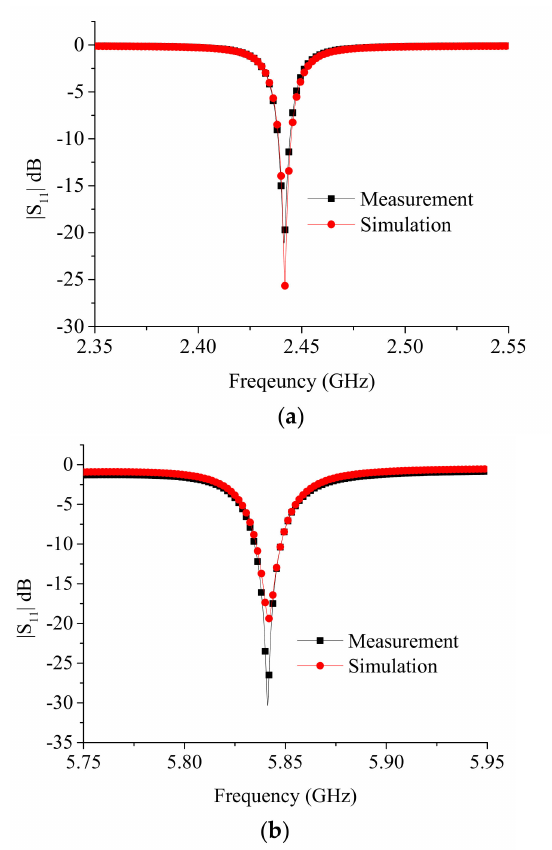
Figure 3. Measured and simulated |S 11 | of the SIW resonator, ( a ) 2.45 GHz, ( b ) 5.85